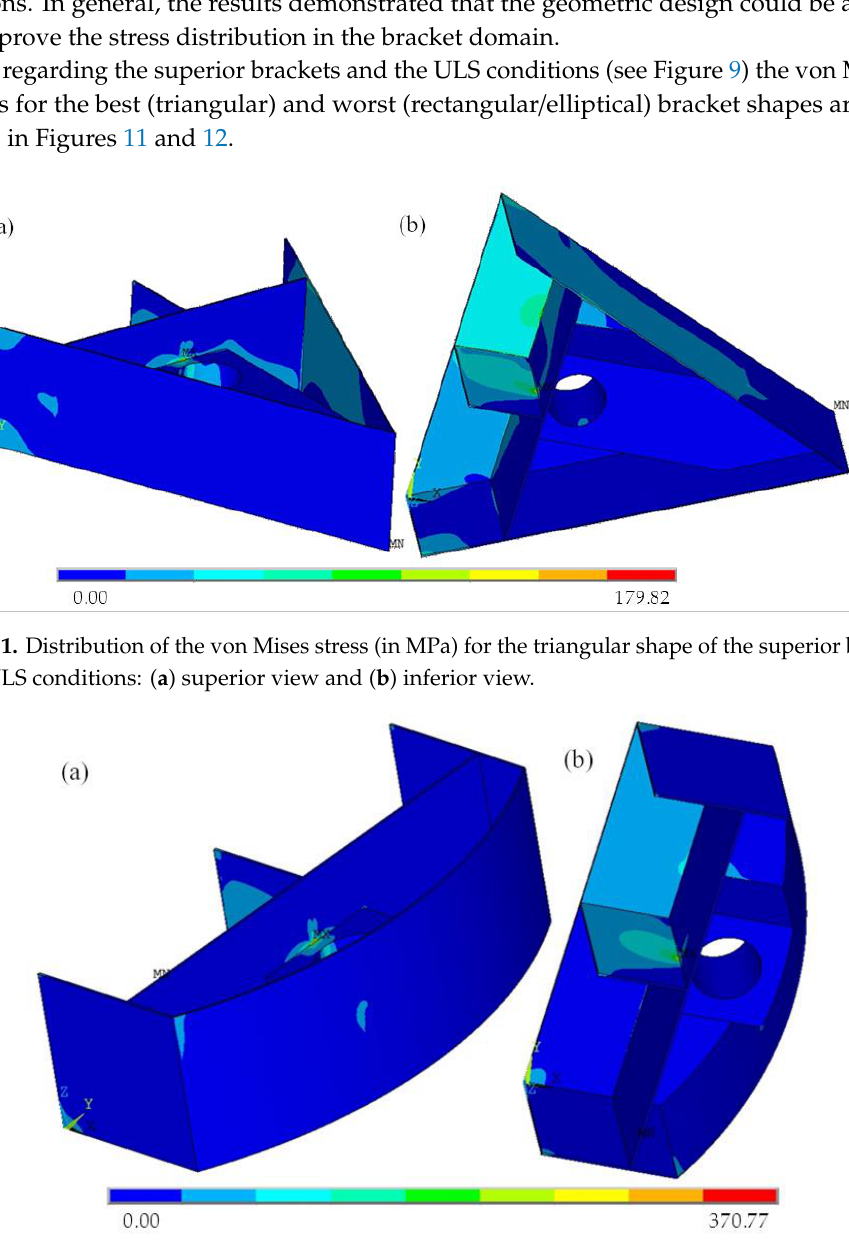
Figure 10. Maximum von Mises stress obtained in the inferior bracket for the six different geometric configurations under the ULS and ALS conditions.